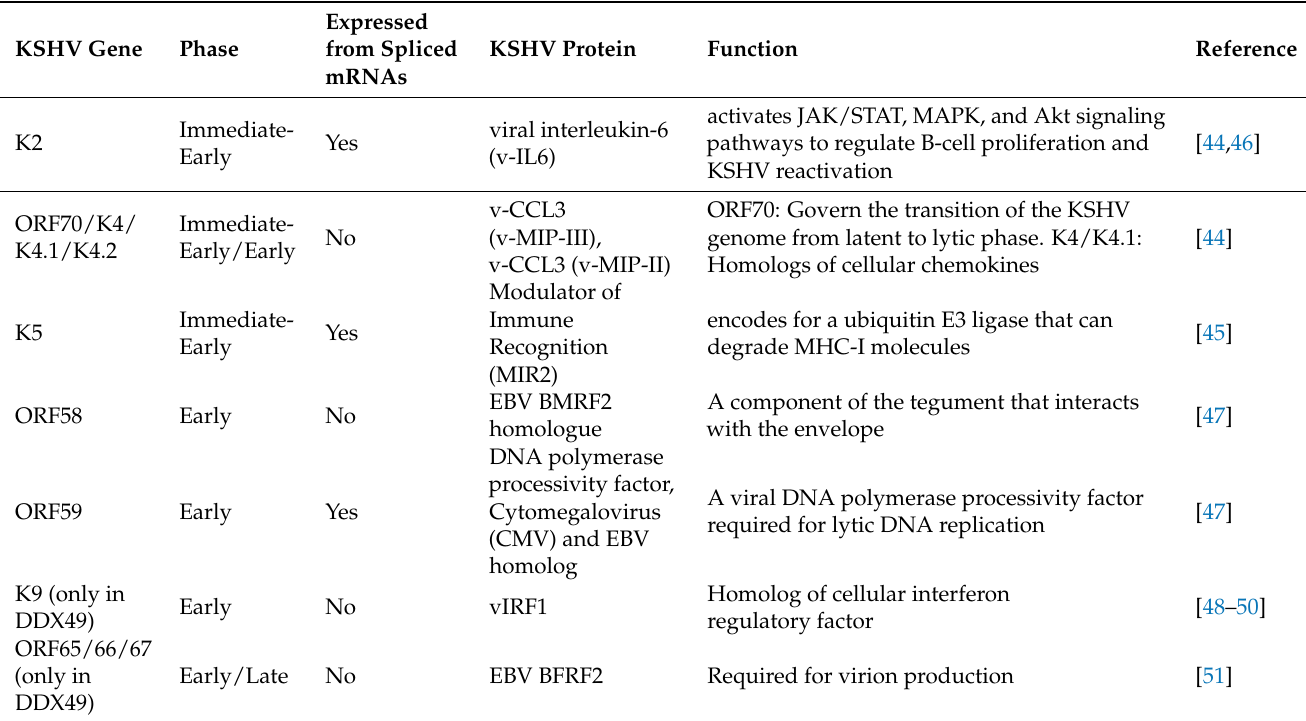
Table 1. List of genes with highly enriched regions from RNA-IP